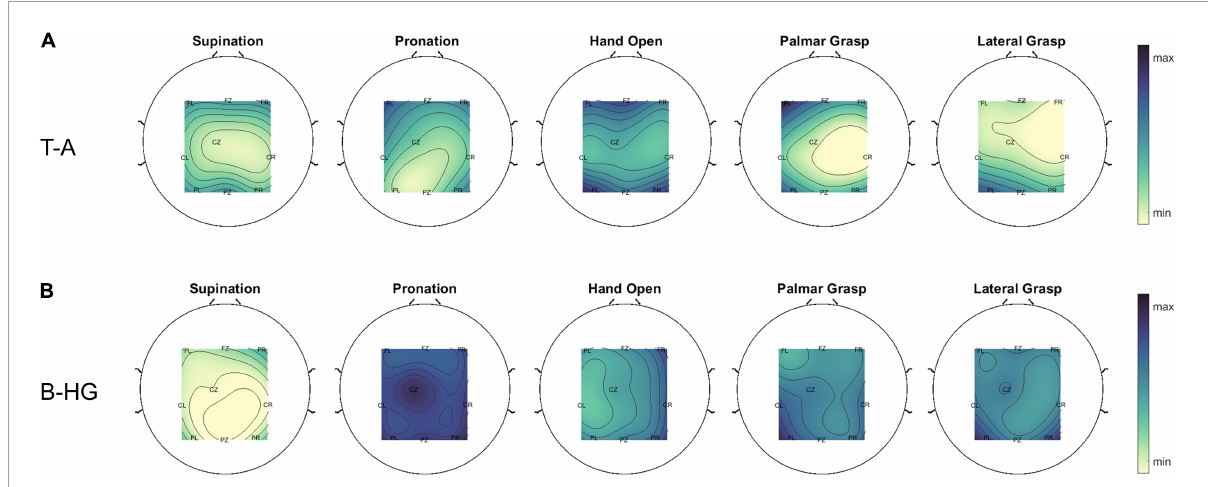
FIGURE7 Average topoplots (over all participants and trials) of the estimated LPV-AR CFC between (A) the phase of the theta band and the amplitude of the alpha band and (B) the phase of the beta band and the amplitude of the high gamma band for the five different movement attempts. In (A,B) , max and min refers to the maximum and minimum value, respectively, obtained from all five movement types.